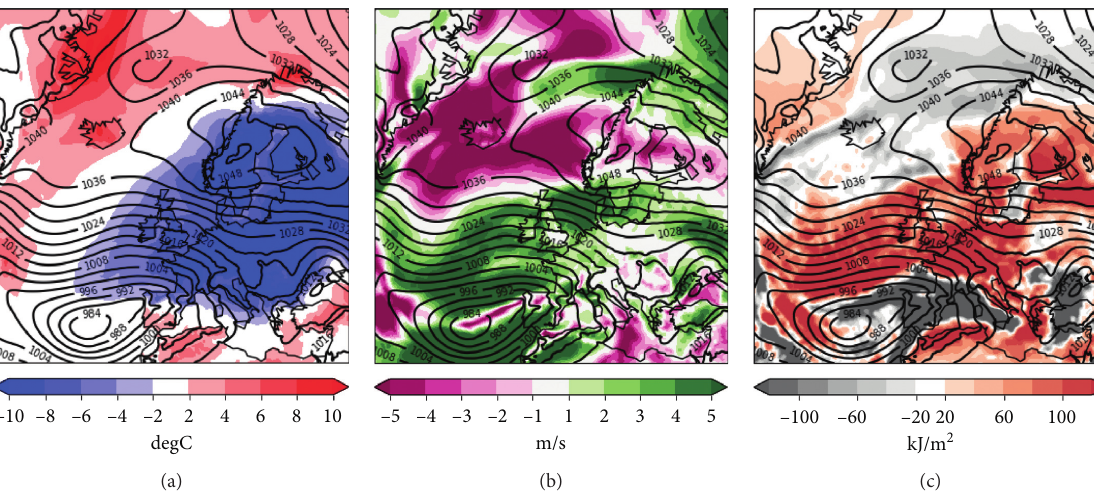
Figure 6: Meteorological anomaly of “the Beast from the East” event, 28 th February 2018. (a) 2m temperature, (b) 100m wind speed, and (c) surface solar